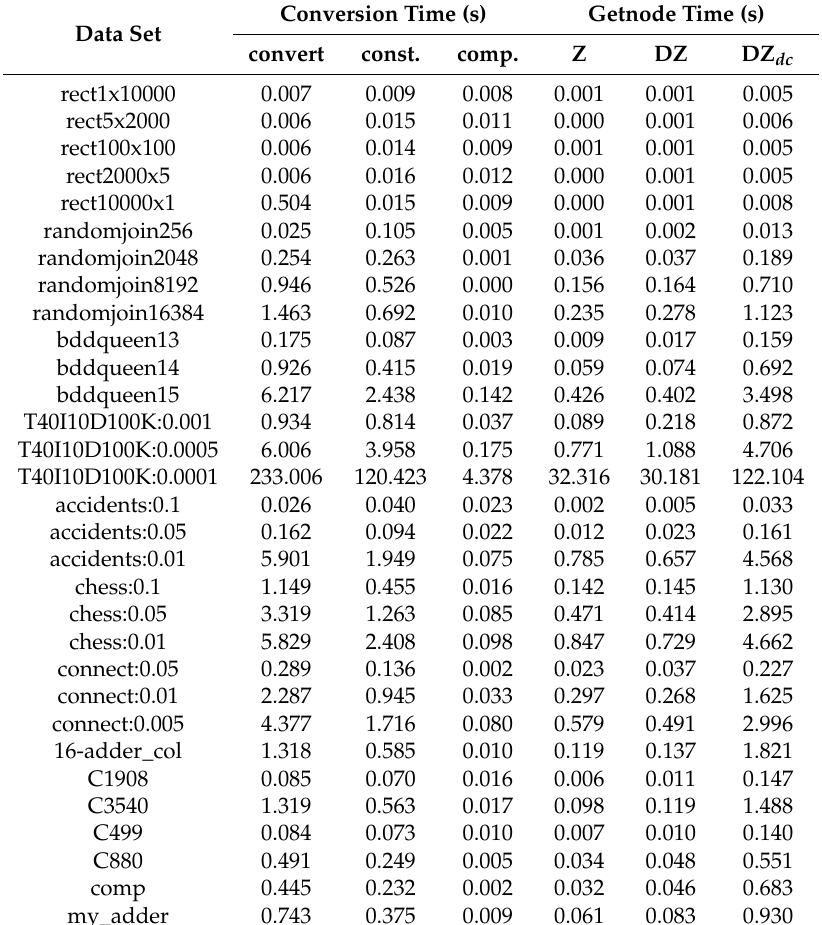
Table 4. Converting time and getnode